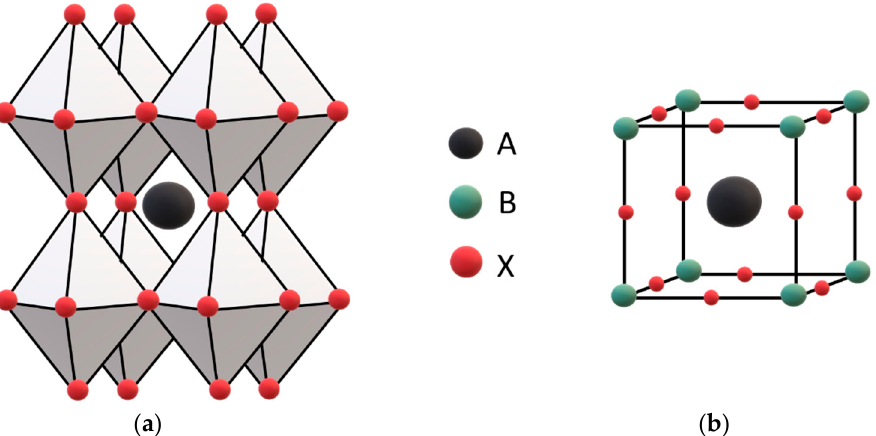
Figure 2. Perovskite arrangement in ABX 3 structure: ( a ) 3D crystalline lattice; ( b ) unit cell of perovskite.